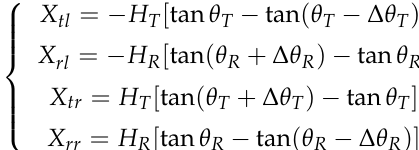
Figure 11. The first line indicates the location of the ghost point and the second line indicates the positional offset between the ghost target point and the real target point along range and azimuth direction when θ T = 29.55 ◦ .